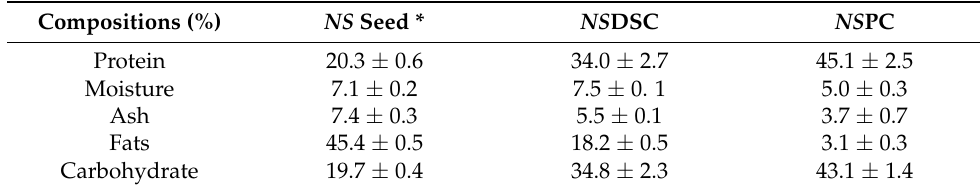
Table 1. Proximate analysis of the Nigella sativa ( NS ) seeds, Nigella sativa defatted seeds cake ( NS DSC), and Nigella sativa protein concentrate ( NS PC), obtained from defatted seeds cake. Compositions (%) NS Seed